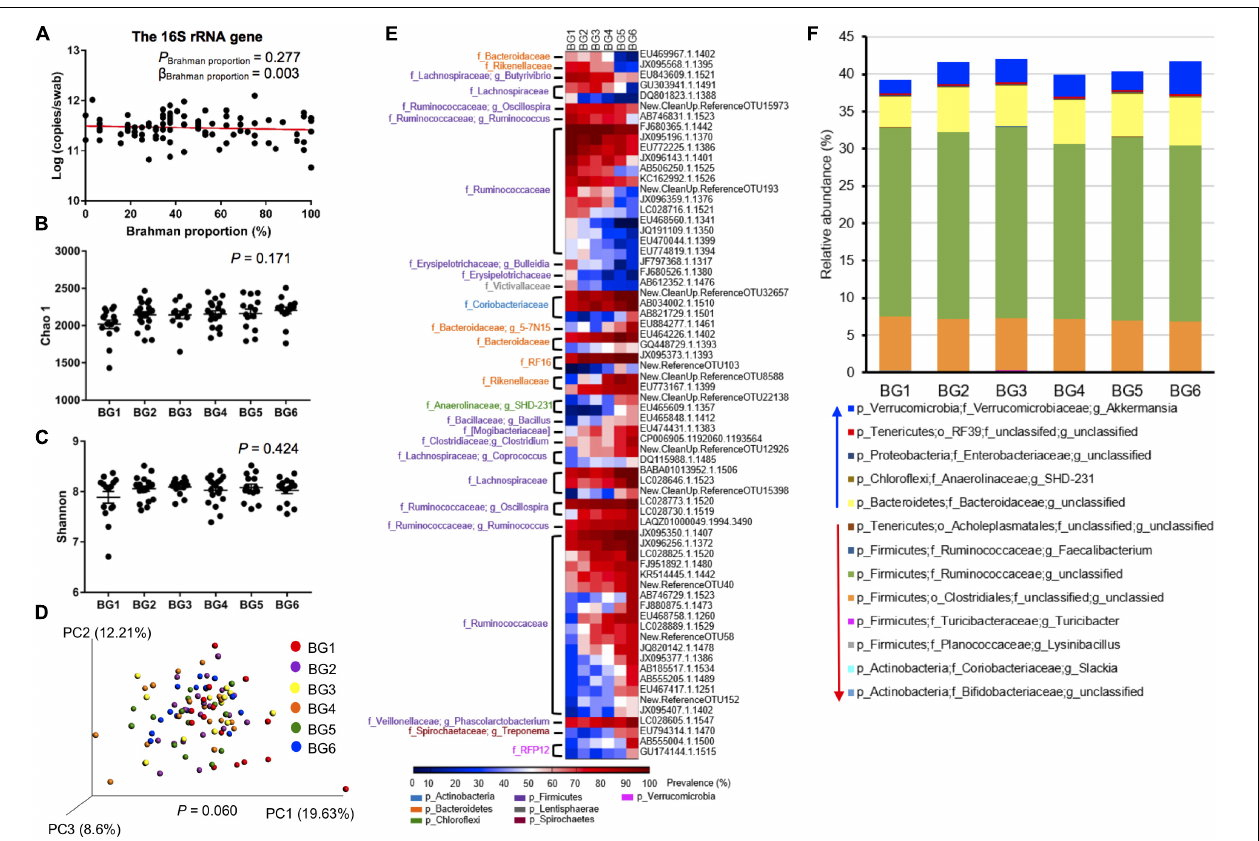
FIGURE 4 | The difference in gut microbiota composition of postweaning heifers among six BGs. The concentration of 16S rRNA gene copy numbers among 95 heifers (A) . For alpha diversity, there is no significant difference in both Chao 1 (B) and Shannon (C) index among six BGs by one-way analysis of variance (ANOVA) followed by Tukey’s HSD test for pairwise comparison of multiple means. However, for β -diversity, the PCoA plot based on weighted uniFrac community distance showing the separation of postweaning heifers among BGs compared by analysis of similarities (ANOSIM) (D) . The heatmaps represent OTU prevalence among six BGs. Only OTUs that were at least classified at the family level and with their prevalence showing a significant positive correlation ( P < 0.01) with breed composition were included in the heatmaps (E) . The relative abundances of core (identified in at least 50% of the samples) bacterial taxa that were linearly influenced by breed composition (F)